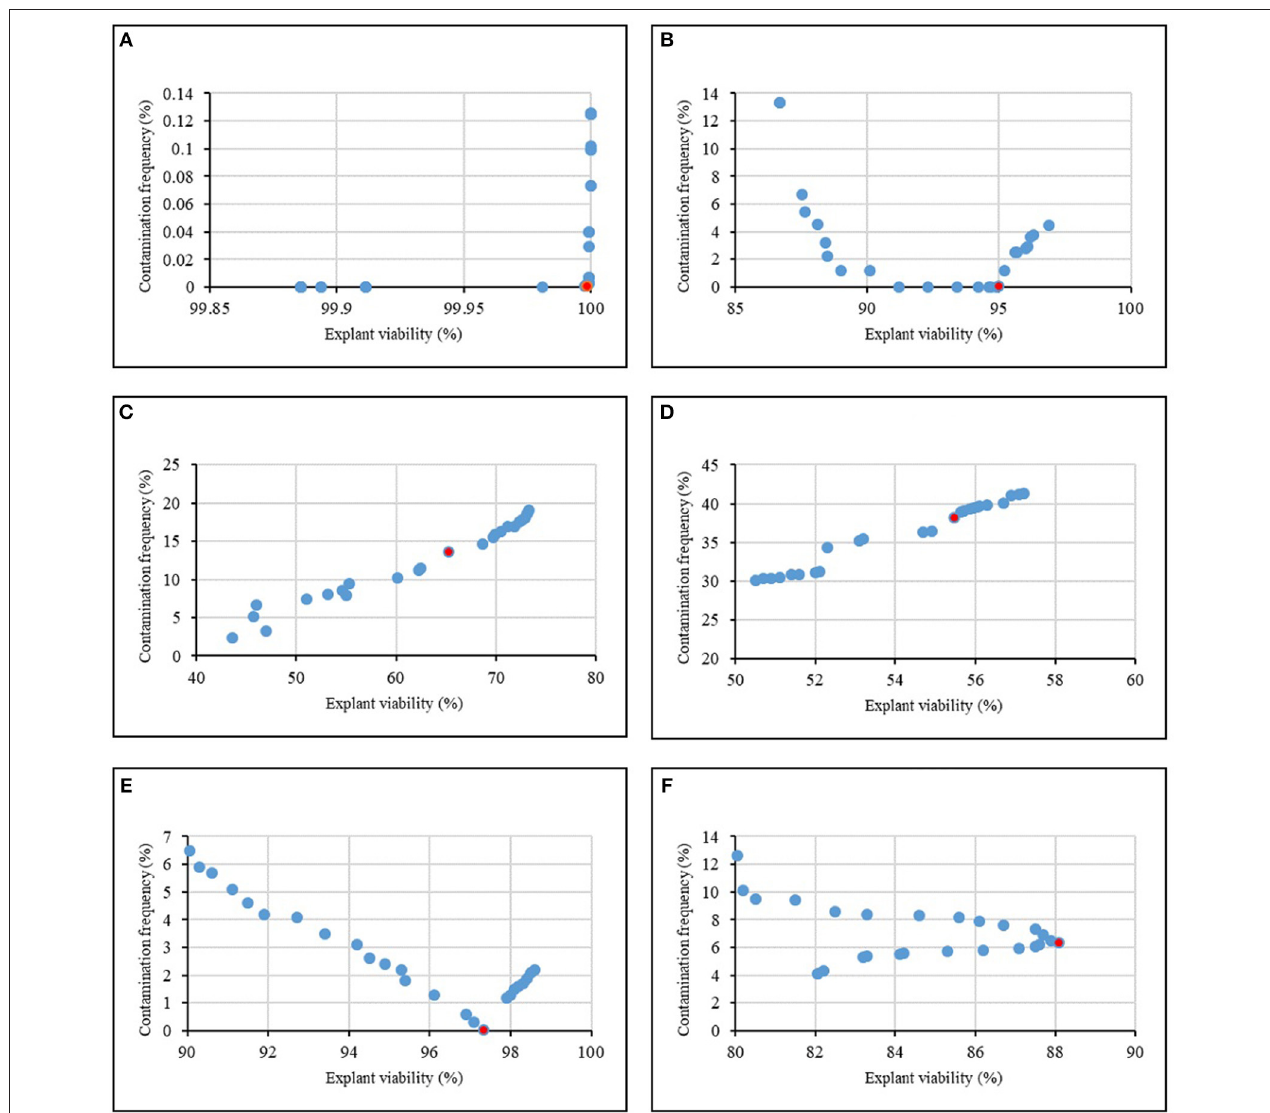
FIGURE 4 | Pareto front obtained by NSGAII for the maximum explant viability and the minimum contamination frequency of chrysanthemum in various sterilants at different immersion times including (A) NaOCl + Time, (B) Ca(ClO) 2 + Time, (C) HgCl 2 + Time, (D) AgNO 3 + Time, (E) H 2 O 2 + Time, (F) Nano-Silver + Time. The red point indicates the ideal